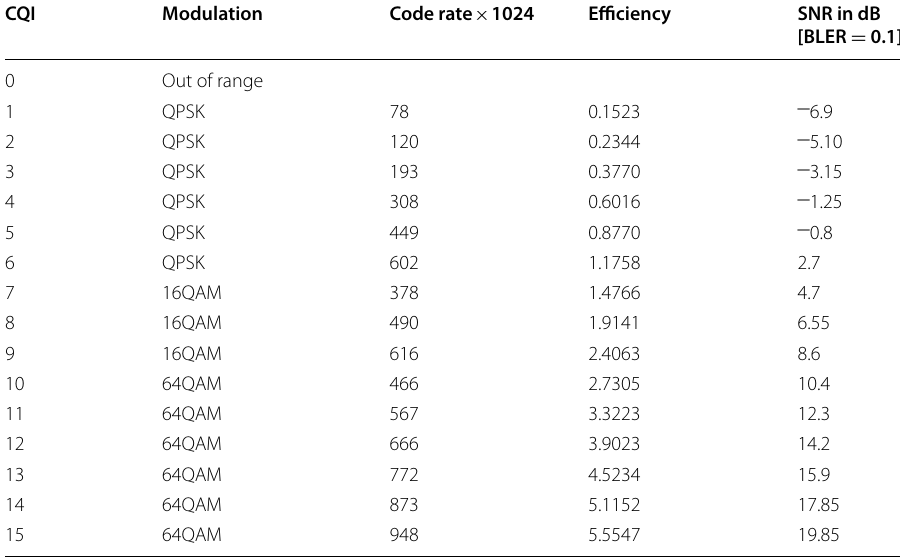
Table 3 CQI table from the existing LTE/NR specifications CQI Modulation Code rate